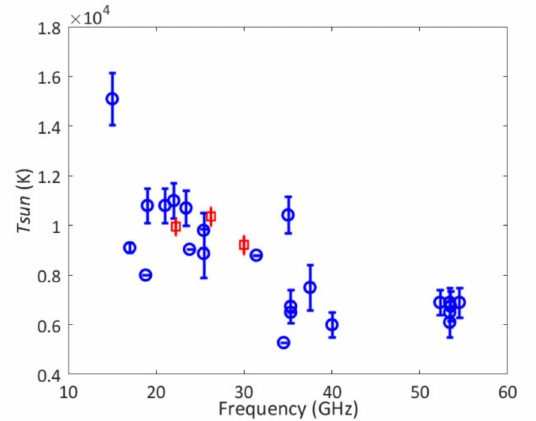
Figure 15. The solar TB versus frequency. The red rectangle represents the mean solar TB observed by the GMR. The blue circle represents the mean TB summarized by Shimabukuro and Stacey (1968) and Mattioli et al. (2016). Tsun is the solar TB and the error bar represents the standard deviation. Some circles have zero standard deviation because the paper did not give the standard deviation in literature.